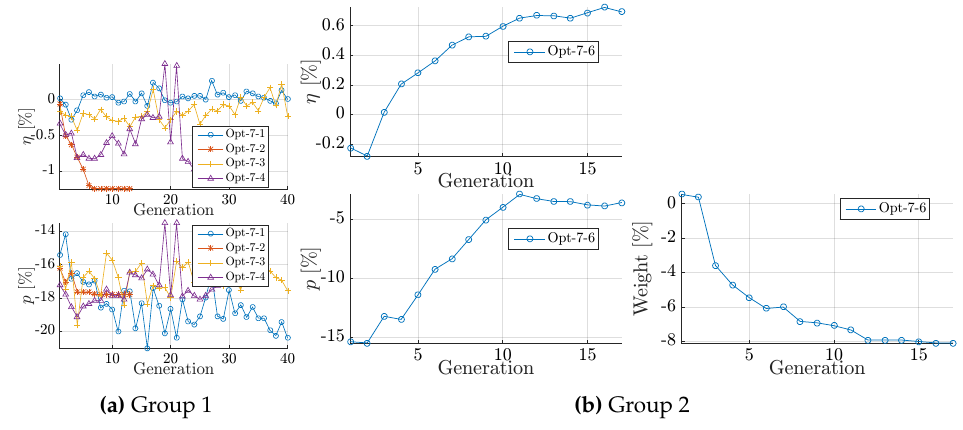
Figure A8. Development of objectives, given as median of relative improvements per generation. ( a ) Group 1; ( b ) Group